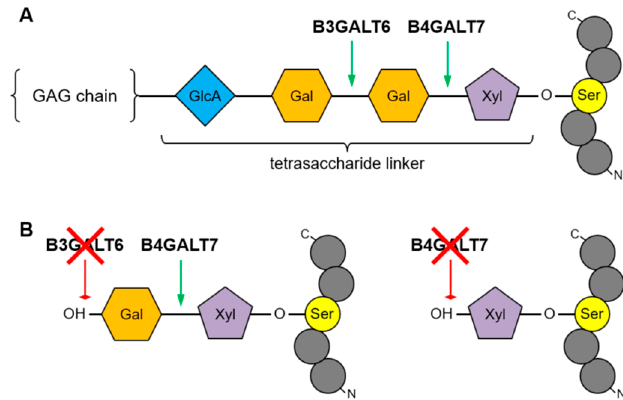
Figure 1. A . Galactosyltransferases I (B4GALT7) and II (B3GALT6) catalyze the addition of galactose units at specific positions of the tetrasaccharide region linking Serine residues on the protein backbone to glycosaminoglycan (GAG) chains. Xyl = Xylose, Gal = Galactose, GlcA = Glucuronic Acid. B . Functional defects of B4GALT6 or B4GALT7 inhibit addition of one or both Gal monosaccharides, respectively, and prevent GAG chain polymerization.